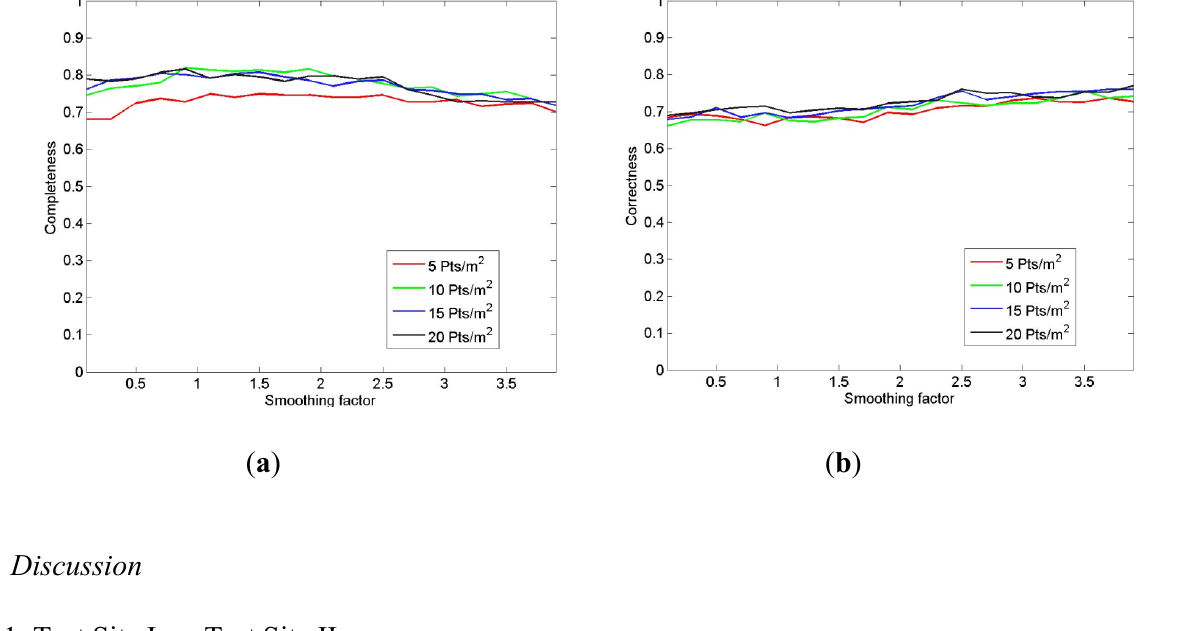
Figure 11. Sensitivity analysis with respect to the parameter λ for the dataset of Test Site II acquired under leaf-off condition; ( a ) Completeness; ( b ) Correctness; colored lines indicate different point